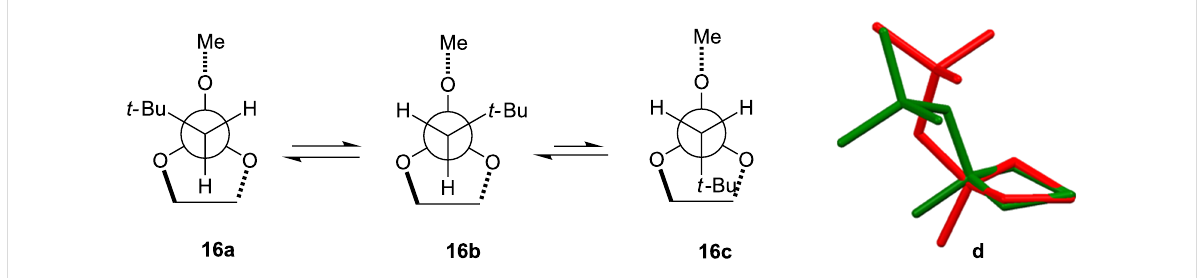
Figure 5: Newman projections [viewed C α –C(2)] of the preferred C 2 arrangement of the 1,3-dioxolane ring depicting the syn ( 16a , b ), anti ( 16c ) conformers, with ( d ) the superimposed calculated syn ( 16a = green) and anti ( 16c = red) structures viewed C(4) → C(5) [the C(2)O– Me group has been removed for